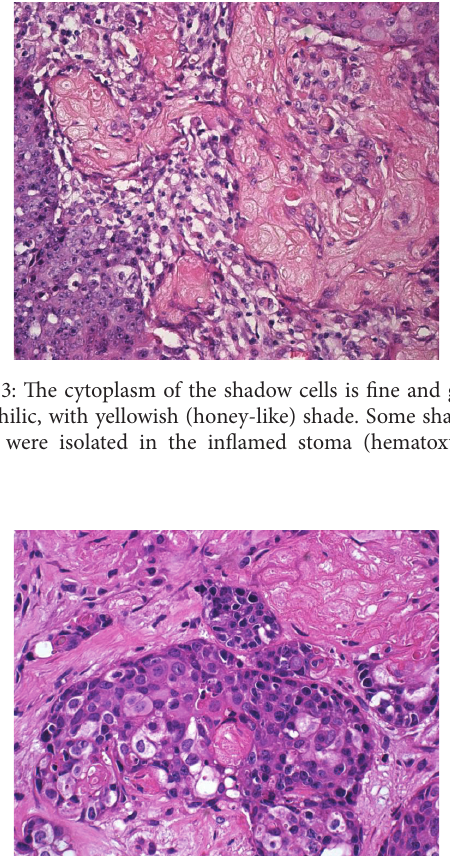
Figure 2: Basaloid morphology of the tumor, with numerous keratinized shadow cells (hematoxylin and eosin).